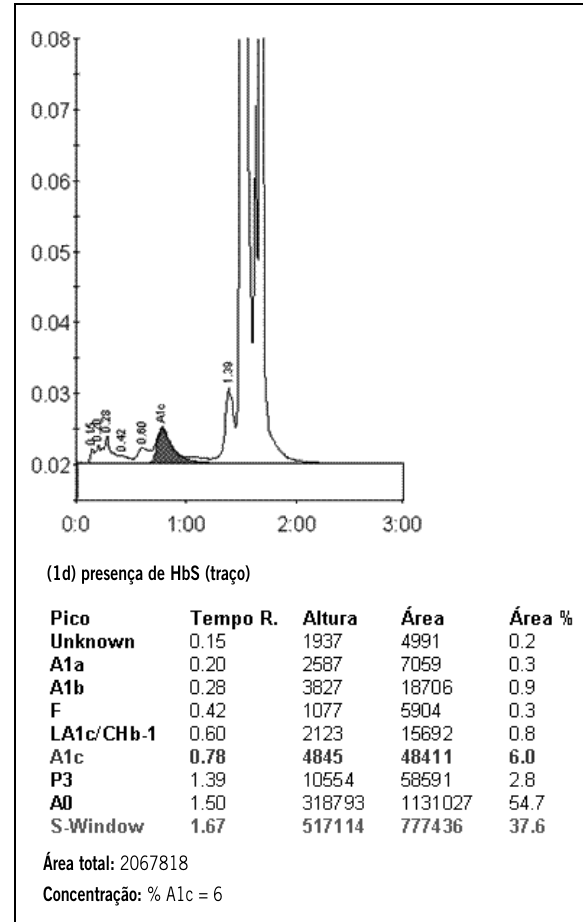
Figura 1d – Cromatograma de hemoglobinas glicadas e parâmetros de análise por CLAE, equipamento D10, Bio Rad; (d) presença de HbS (traço). Pico de A1C mostrado em hachurado CLAE: cromatografia líquida de alta eficiência; Hb: hemoglobina; R: retenção; P3: indicador de qualidade de